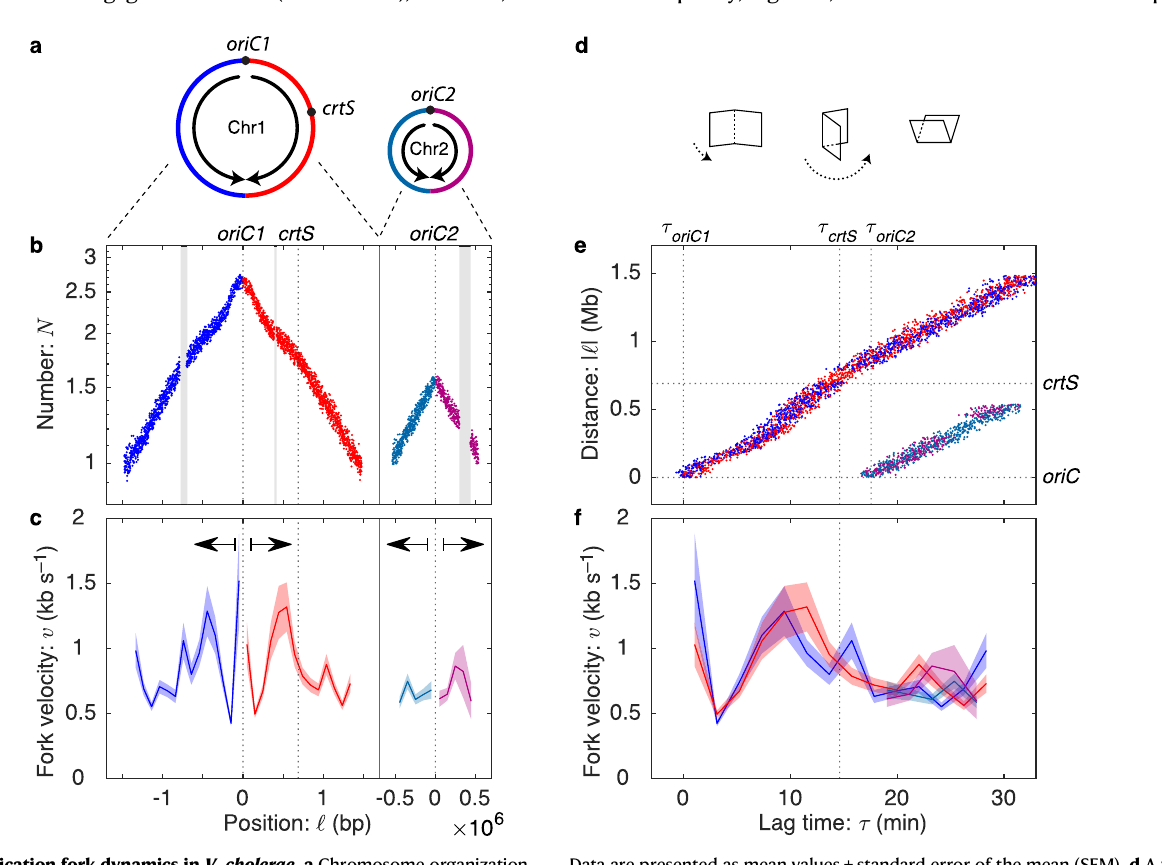
Data are presented as mean values±standard error of the mean (SEM). d A visual representation of the relation between the log-marker-frequency and lag-time plots:Foldattheoriginandrotate. e Lag-timeanalysis.Thereplicationforksstartat theoriginatlagtimezeroandthenaccelerateanddeceleratesynchronously,asthe forksmoveawayfromtheorigin.Theconsistencyinarmpositionisamanifestation of bilateral symmetry. f Fork velocity as a function of lag time. In addition to bilateral symmetry, after Chr2 initiates, all four forks show roughly consistent velocities.